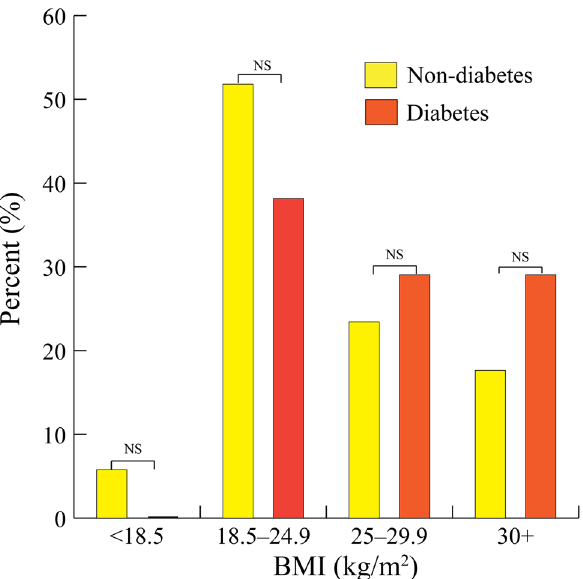
Figure 4. Body mass index by diabetic status, Nièna, Mali, 2021. The first and second columns show the percentage of non-diabetes and diabetes subjects for each body mass index (BMI) classification. The percentages of non-diabetic and diabetic subjects did not statistically differ within the BMI